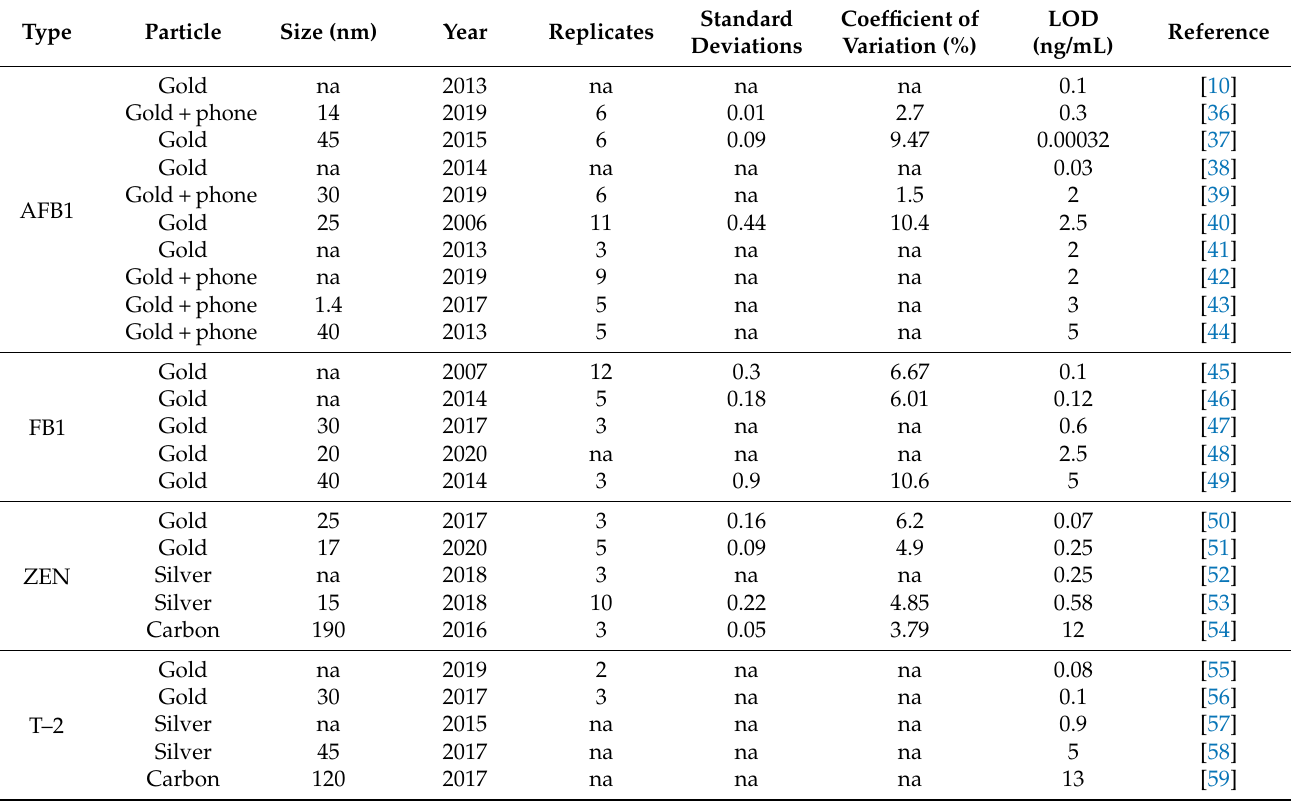
Table 1. Papers with limit of detection of